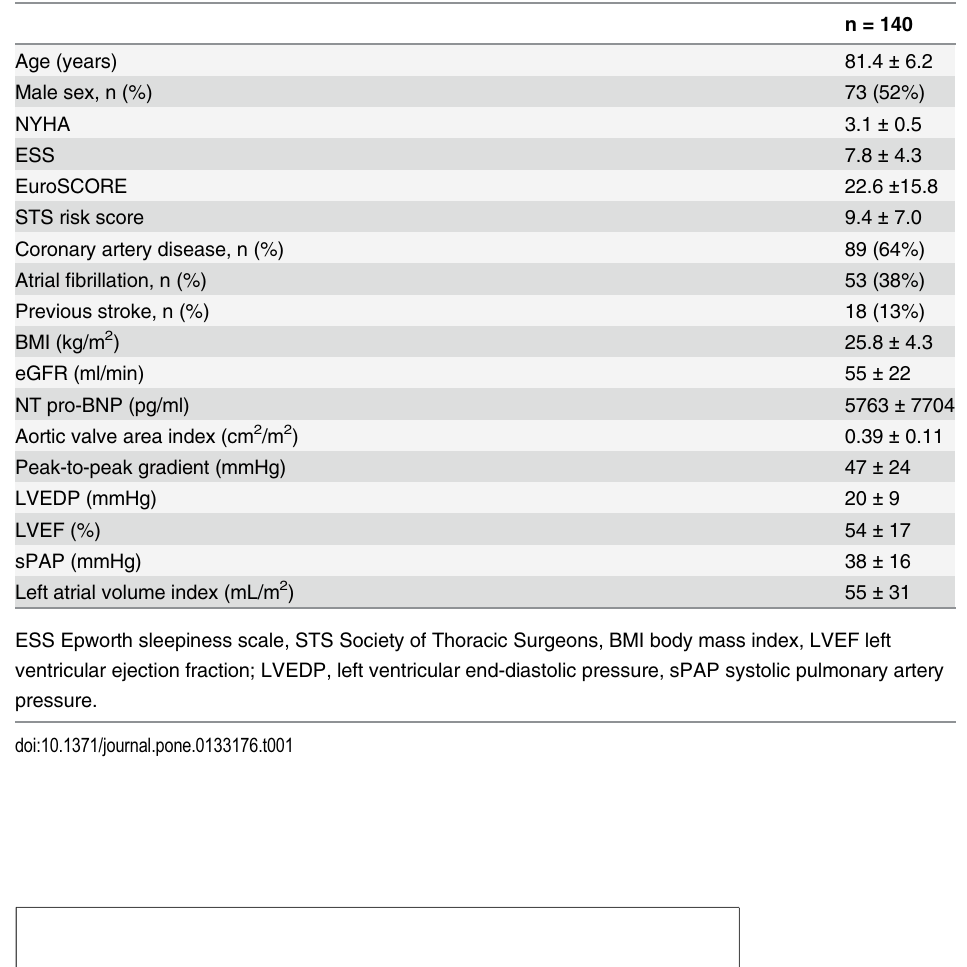
Table 1. Baseline patient characteristics.